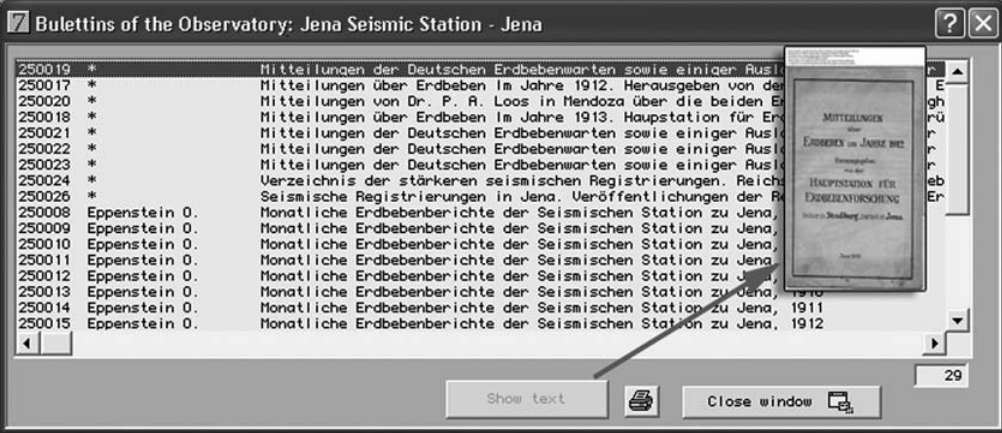
Fig. 5. Bulletins file, consultation window of all the bulletins present in the data base, relating to the selected observatory. By highlighting a record from the list of bulletins it is sufficient to press the button «Show text» to open the PDF file containing the digital scan of the original